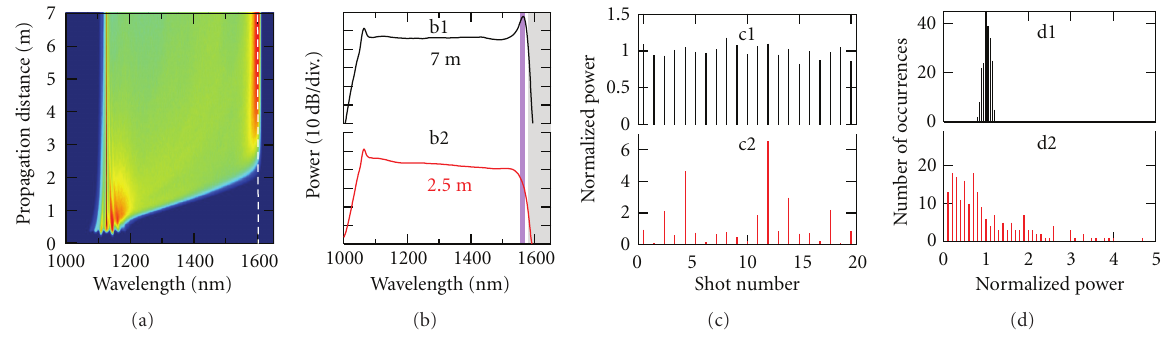
Figure 12: (a) Simulation of the spectral broadening as a function of propagation distance in the solid-core PBG fiber 3 (averaged over 200 simulation shots). The white dashed line represents the PBG edge. (b) Simulated averaged spectra for fiber lengths of 7m (b1) and 2.5 m (b2). (c1 and c2) Samples of corresponding pulse train after spectral filtering at 1562 nm (depicted by the purple region in (b)). (d1 and d2) Corresponding histograms over 200 pulses at 1562 nm, where the power is normalized to its average over the 200